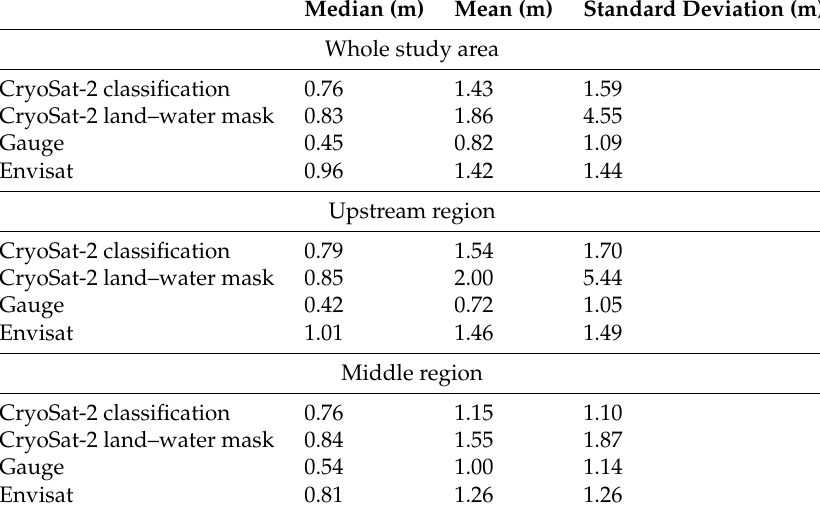
Table 3. Analysis of the differences of height measurements 369 days apart for the whole study area, only the upstream region, and only the middle stream region.